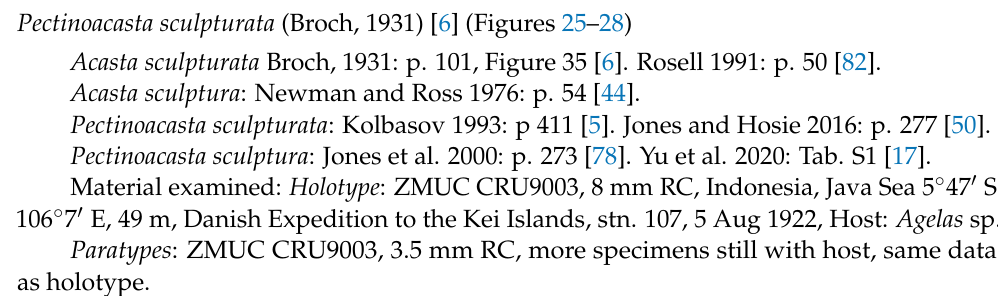
Figure 23. Pectinoacasta pectinipes (Pilsbry, 1916) cirri I–III (WAM C58871). ( A ) Left cirrus I; ( B ) terminal segment of cirrus I anterior ramus; ( C ) left cirrus II; ( D ) terminal segment of left cirrus II posterior ramus; ( E ) left cirrus III; ( F ) medial segments of cirrus III anterior ramus. Scale bars: A, C, E = 200 µ m; B, D, F = 50 µ